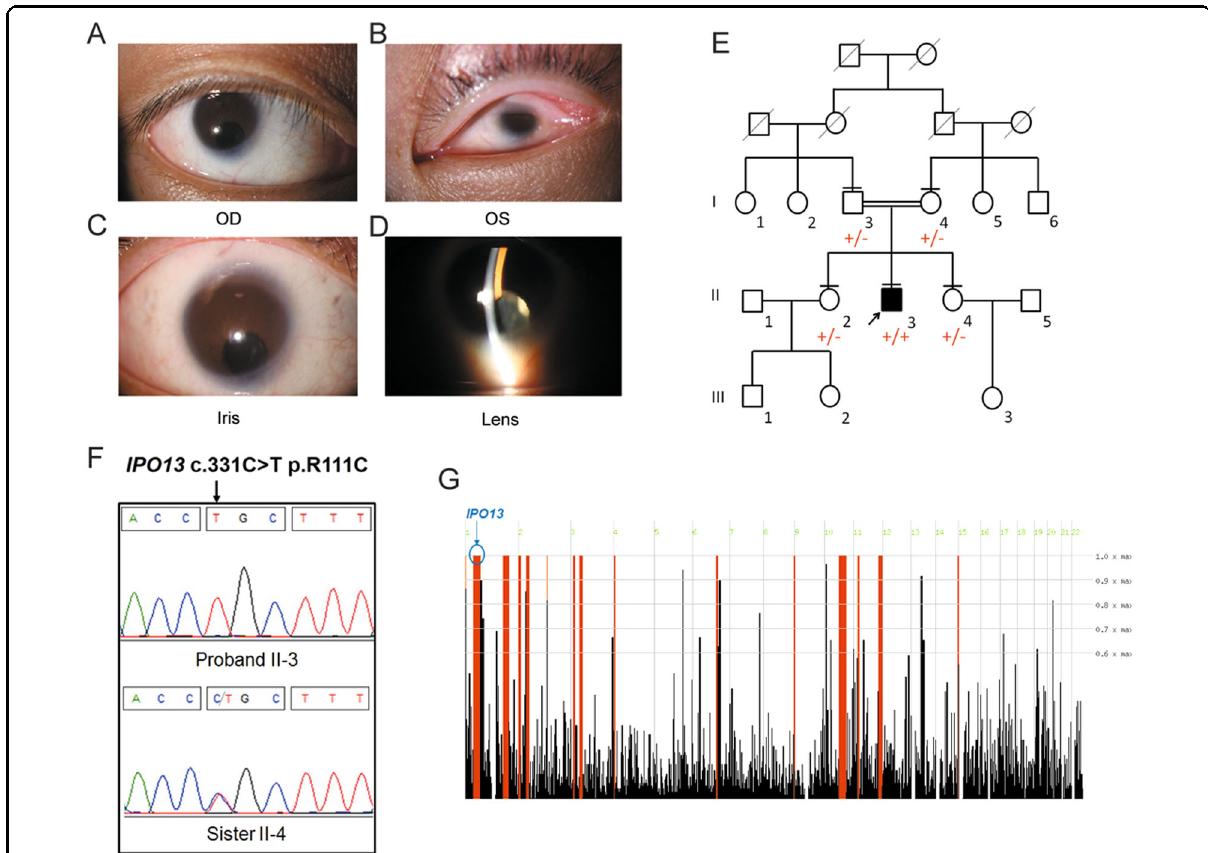
Fig. 1 Identi fi cation of IPO13 mutation in a patient with coloboma, microphthalmia, and cataract. a – d Clinical manifestations of patient. a , b Slit-lamp photographs of the patient with congenital cataract and microcornea. OD right eye, OS: left eye. c Iris coloboma. d Pictures of lens from the proband show opacities in the right eye. e Three-generation pedigree. Affected individual is represented as a fi lled square. Normal individuals are shown as empty symbols. f Sequence chromatograms of IPO13 in the patient and a sibling. g Homozygosity mapping analysis (using HomozygosityMapper) shows a 44.4 Mb locus of homozygosity on chromosome 1, which contains the IPO13